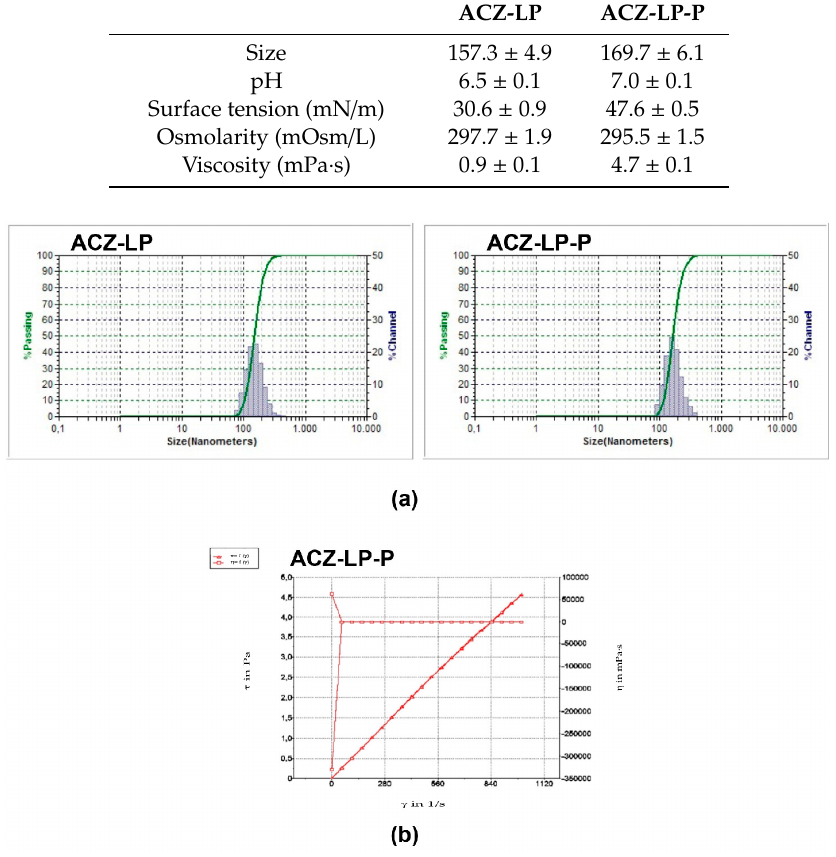
Figure 1. ( a ) Particle size distribution and ( b ) rheological behaviour of formulations composed by acetazolamide-loaded liposomes alone (ACZ-LP) or in combination with HPMC (ACZ-LP-P).